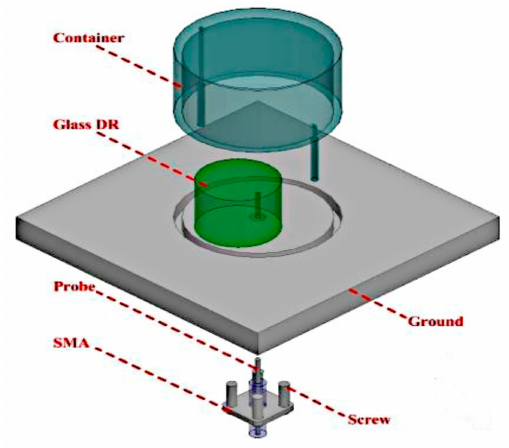
Figure 36. Reconfigurable dielectric resonator antenna (DRA) presented in